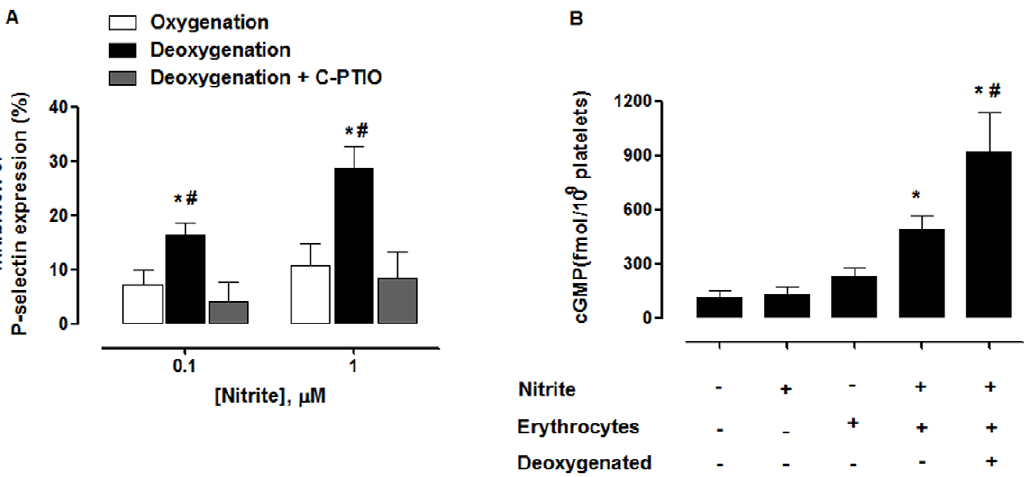
Figure 5. Deoxygenation enhanced platelet inhibition by nitrite + erythrocytes. PRP was pre-incubated with nitrite (0.1 or 1 m M) or nitrite + C-PTIO (200 m M) in the presence of oxygenated or deoxygenated erythrocytes (20% hematocrit) for 5 min. Then, 20 m M ADP was added to the cell suspension and incubated for 10 min. Platelet activation was determined by the flow cytometry as an expression of P-selectin. * P , 0.05 compared with the values of oxygenated erythrocytes. # P , 0.05 compared with deoxygenated erythrocytes + C-PTIO (ANOVA). (B) Nitrite + erythrocytes increase the cGMP levels in platelets. Washed platelets + erythrocyte samples (20% hematocrit) were incubated with 0.1 m M nitrite for 5 min. * P , 0.05 compared with platelets. # P , 0.05 compared with platelets + nitrite + erythrocytes (ANOVA). All experiments were performed at 37 u C. Data are